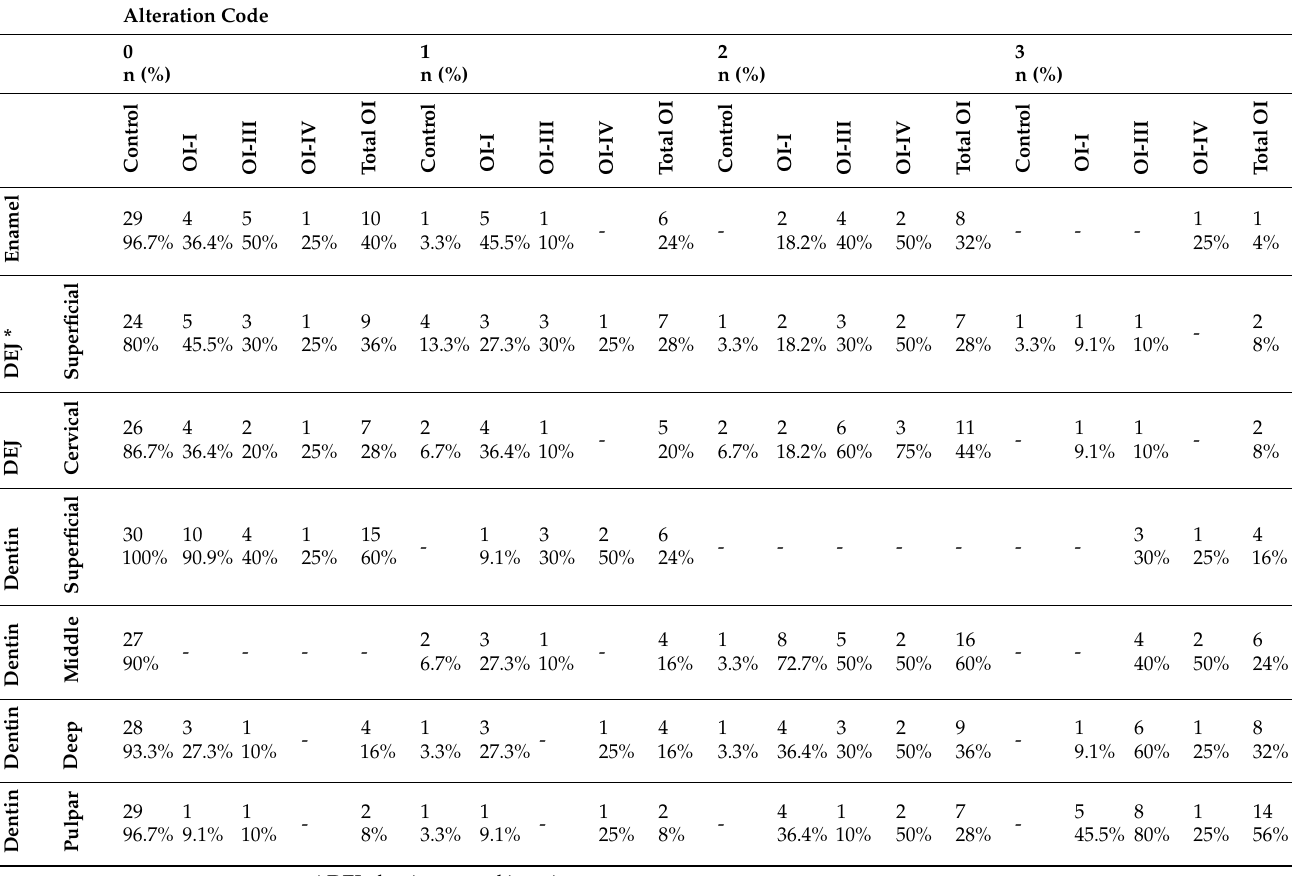
Table 5. Frequency and percentage of morphological alterations at the different study levels.